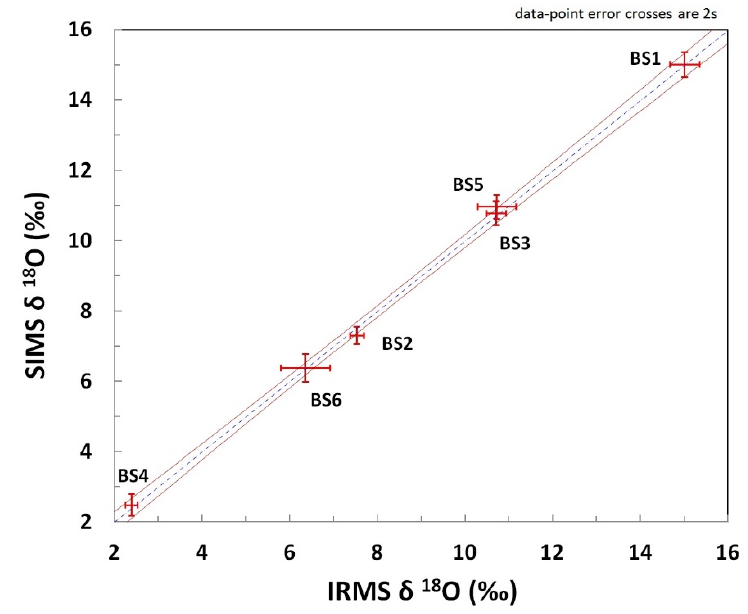
Figure 6. δ 18 O (SIMS) vs. δ 18 O (IRMS) of the six samples.